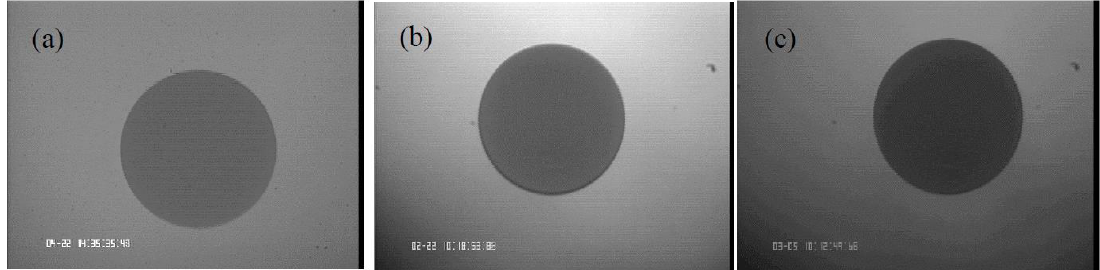
Figure 7. Sample images of ( a ) W, ( b ) Re, and ( c ) Os at their melting temperature.